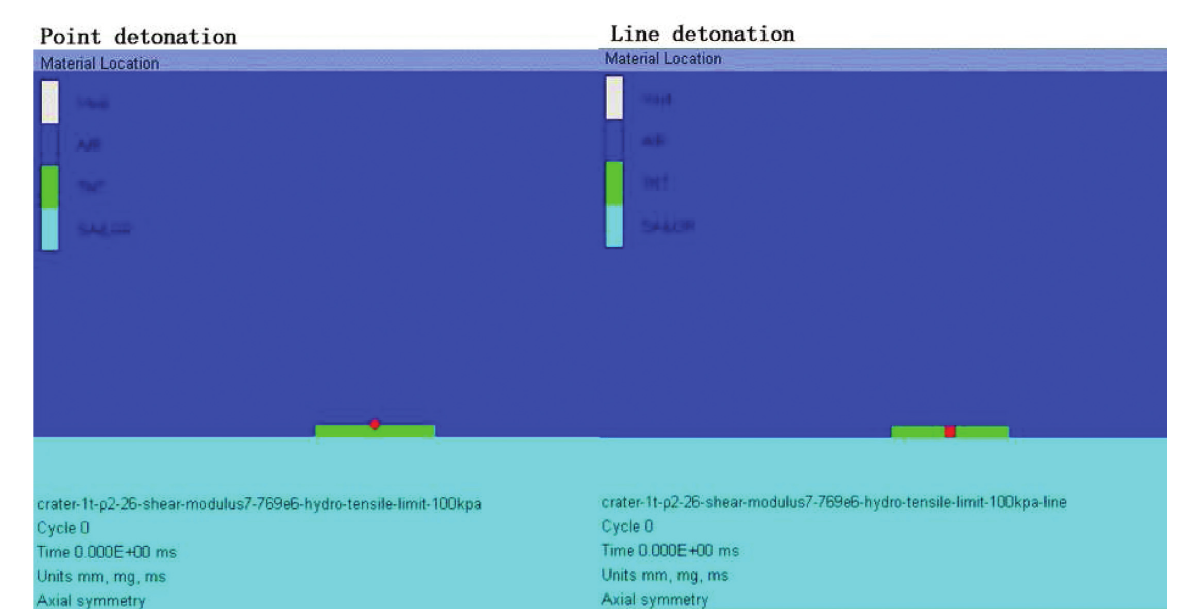
Figure 8: Two types of initiation modes.